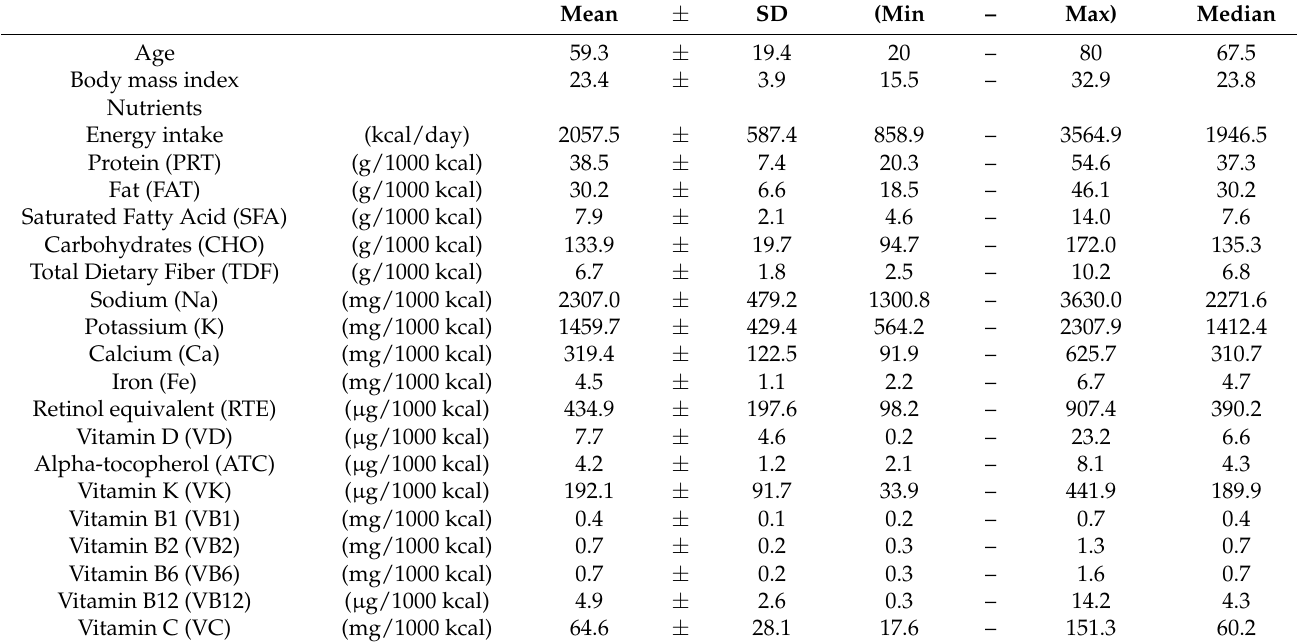
Table 1. Participant characteristics and mean scores of nutrient intake ( n =